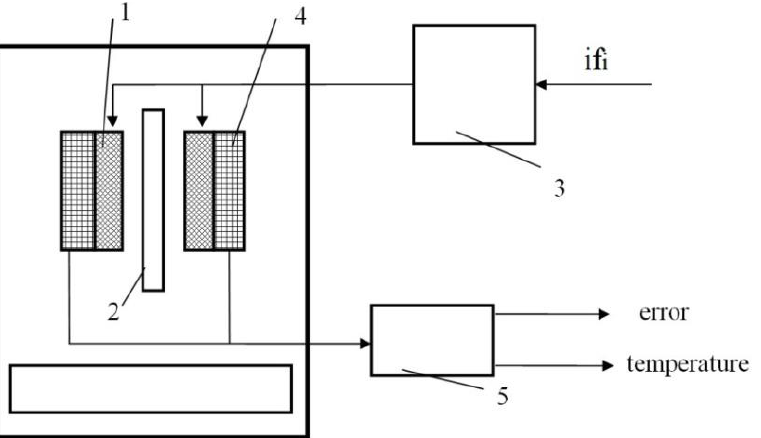
Figure 2. Functional block diagram of the testbed system: ( 1 ) the induction heating coil; ( 2 ) the nozzle; ( 3 ) high frequency (HF) inverter; ( 4 ) the sensing coil; ( 5 ) the unit for recording and processing a measuring signal (ARM-microcontroller).